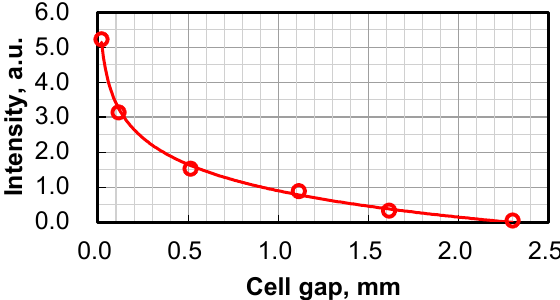
Figure 4. Thickness of glycerol layer versus the transmitted intensity of a laser beam.